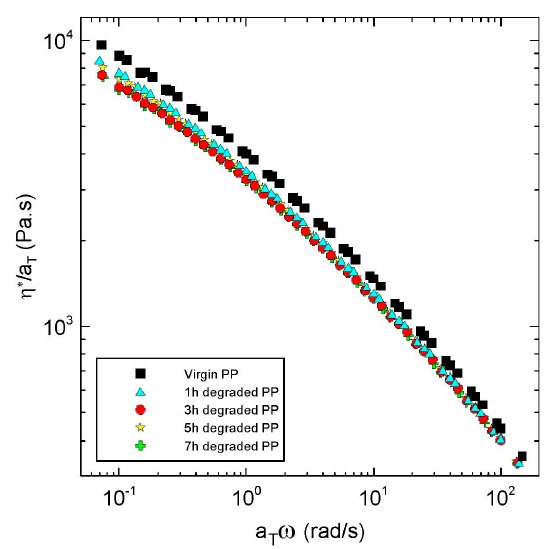
Figure 2. Frequency-dependent complex viscosity, η *, for virgin and degraded polypropylenes at 180 °C.